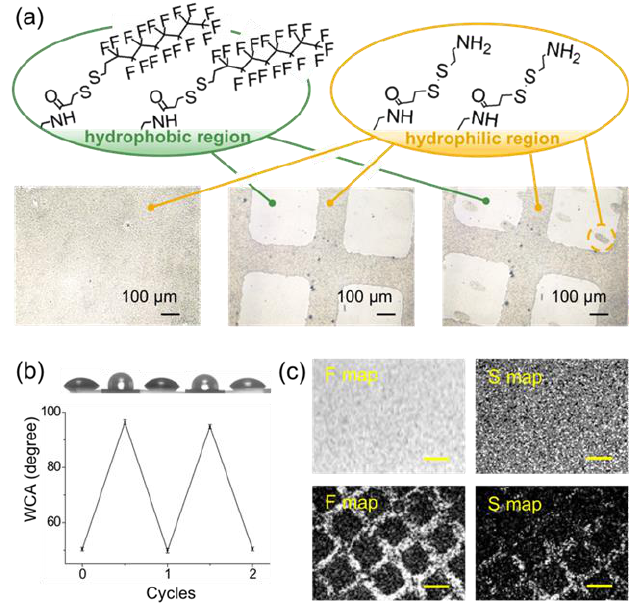
Figure 3. FT-IR spectral characterization used to monitor the surface chemistry modifications for the erasable coating. The FT-IR spectra were recorded to compare ( a ) the as-deposited erasable coating with ( b ) the erased treatment of the coating, ( c ) the conjugation with cysteamine, and ( d ) the conjugation with perfluorodecanethiol. The surface modifications were conducted on the same sample surface.